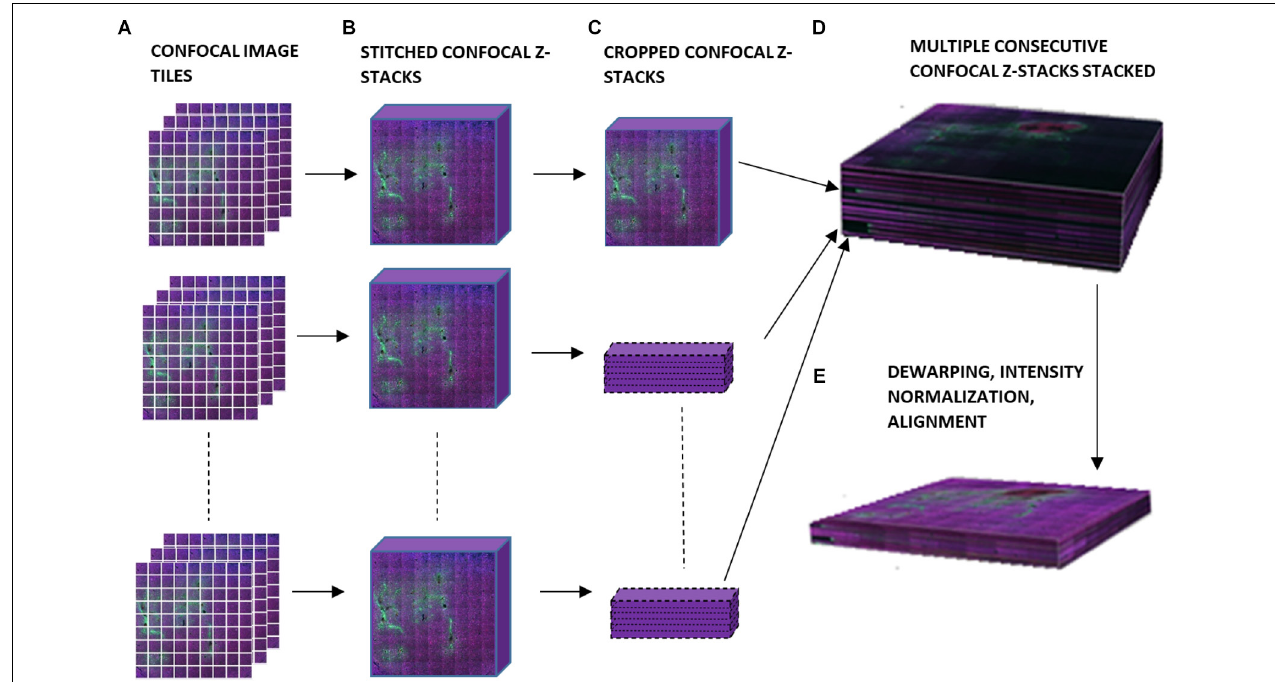
FIGURE 2 | Schematic of workflow for 3D image reconstruction, illustrating (A) confocal image tiles, (B) stitched confocal z -stacks, (C) confocal z -stacks cropped to the same x and y dimensions, (D) stacked confocal z-stacks, and (E) the final 3D volume after dewarping, intensity normalization, and alignment.